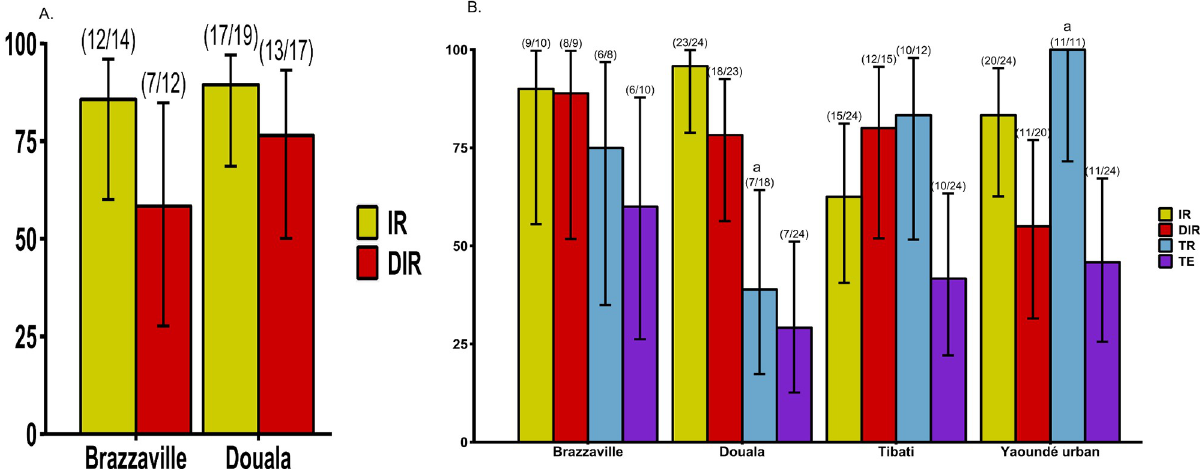
Fig 2. Infection, dissemination, transmission rates and transmission efficiency of Ae . albopictus from Central Africa. A) Infection and dissemination rates at 14 days post-exposure (dpe). B) Infection, dissemination, transmission rates and transmission efficiency at 21 dpe. Error bars show the 95% confidence interval. In brackets, the number of mosquitoes examined. IR: the proportion of mosquitoes with infected body among engorged mosquitoes; DIR: the proportion of mosquitoes with infected head among mosquitoes with infected body; TR: the proportion of mosquitoes with infectious saliva among mosquitoes with infected head. The lowercase letter on the top of some indices indicates the significant difference for pairwise comparisons. When the same letter is shared by several populations, this indicates that the difference is significant ( P < 0.05) between them.